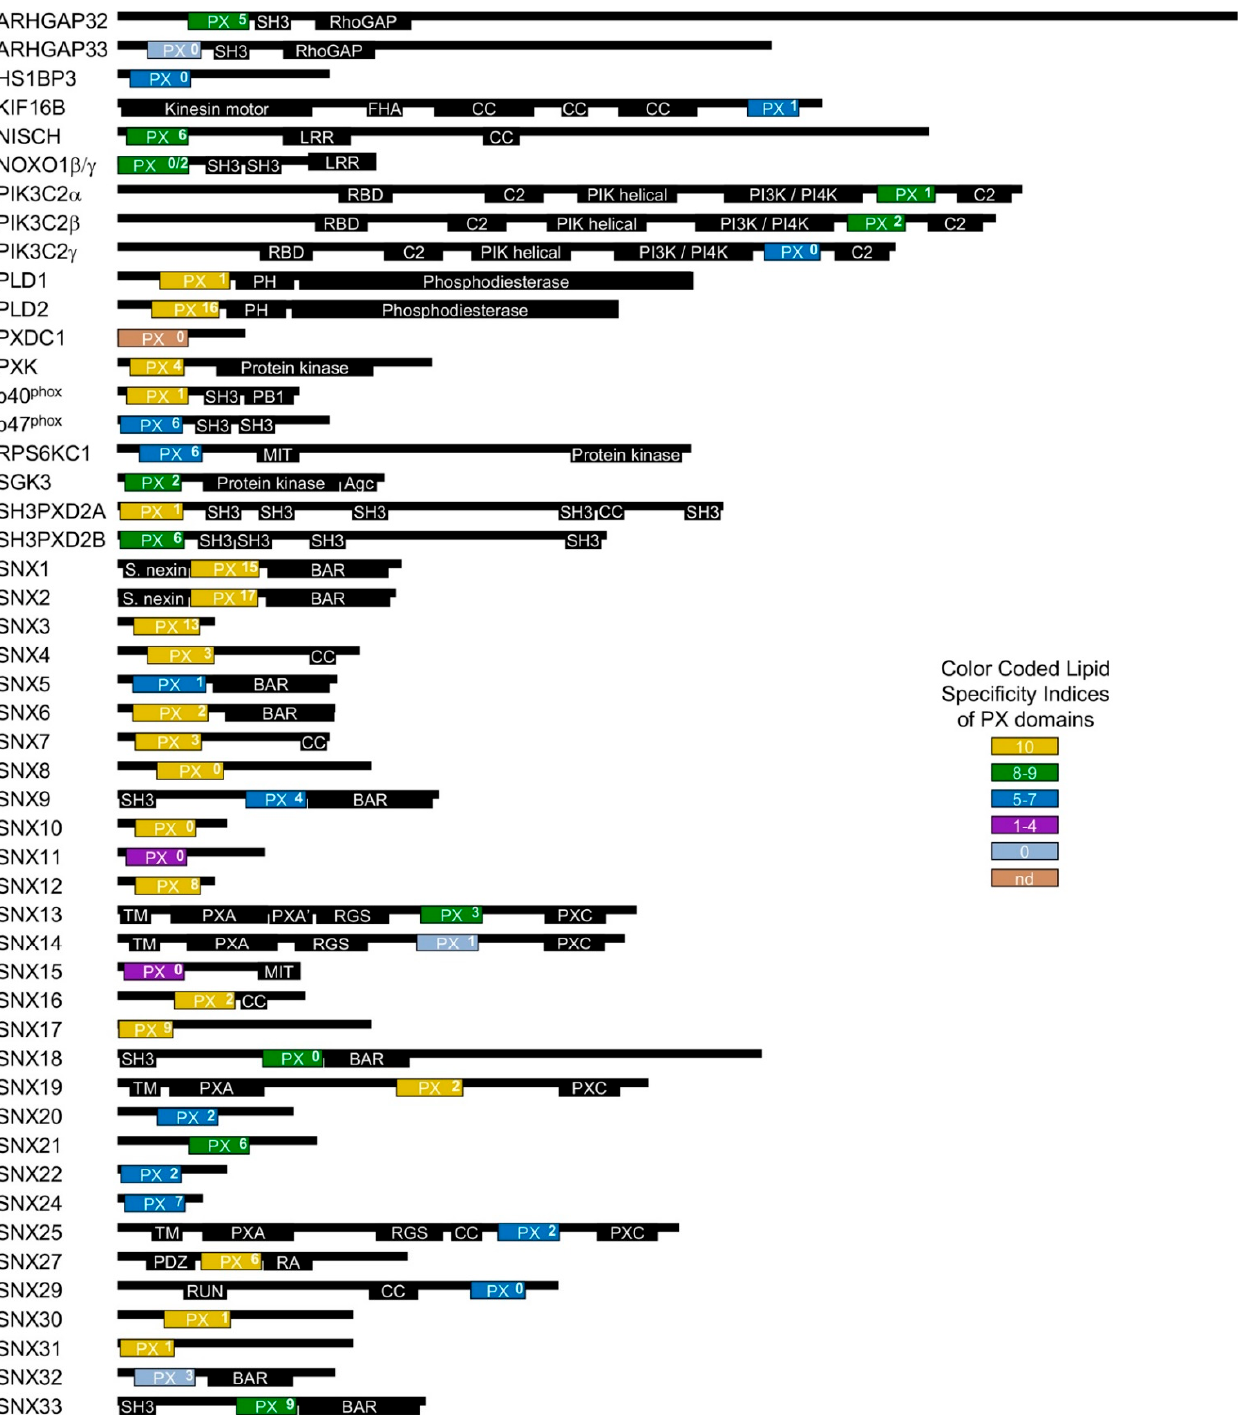
Figure 1. Human PX domain-containing proteins. PX domains are shown as boxes colored by specificities as in Figure 2 with PSS values superscripted. Other domains are black and labelled as Agc (AGC kinase C-terminal), BAR (Bin–Amphiphysin–Rvs), C2 (protein kinase C conserved region 2), CC (coiled coil), GAP (GTPase-activating protein), FHA (forkhead-associated), LRR (leucine-rich repeat), MIT (microtubule interacting and transport), PB1 (Phox and Bem1), PDZ postsynaptic density 95, disk large, zonula occludens), PH (pleckstrin homology), PIK (phosphoinositide 3-kinase), PXA (PX-associated), PXC (PX C-terminal), RA (Ras-associating), RBD (Ras binding domain), RGS (regulator of G protein signaling), RUN (RPIP8, unc-14 and NESCA), SH3 (src homology 3), or TM (transmembrane).